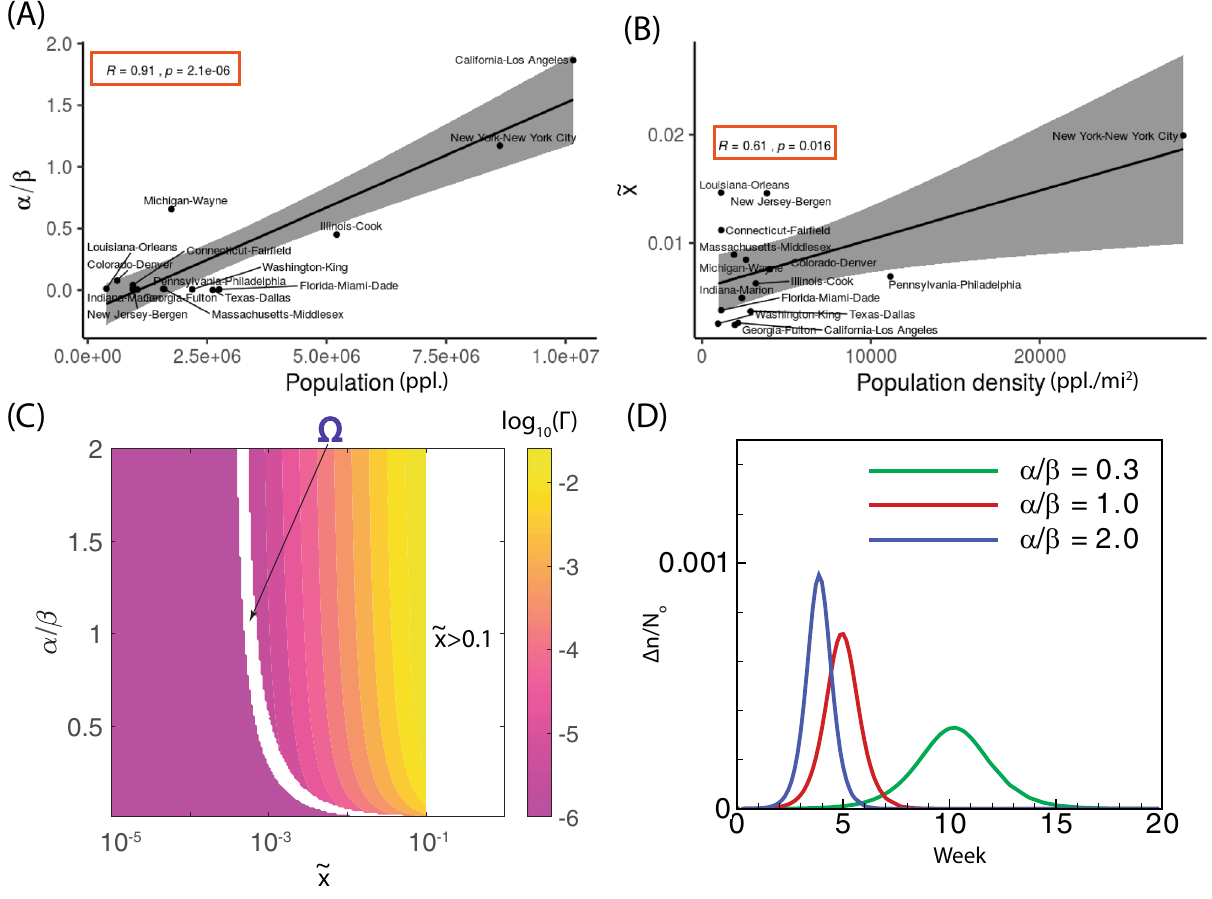
Figure 2. Relationship between county population and α/β & ˜ x . ( A , B ) The statistical correlations (R: Pearson correlation coefficient) are displayed for ( A ) virulence ( α/β ) vs. the corresponding county population and ( B ) the projected infection fraction ( ˜ x ) vs. the corresponding county population density (sample number is 15). The solid line is the linear regression with a grey shaded area of 95% confidence interval. ( C ) A phase diagram in terms of α/β and ˜ x for the peak infection rate Ŵ ; domain ‘ (cid:31) ’ represents the region in which the peak infection is not reached and Region {˜ x > 0.1 } indicates the unlikely space where total infection exceeds 10% of the total population in the domain considered. ( D ) The effect of dimensionless parameter α/β on peak infection is studied with ˜ x = 0.01 . For ( C , D ), the simulations are conducted for a duration of 1 year (365 days) with T inf = 40